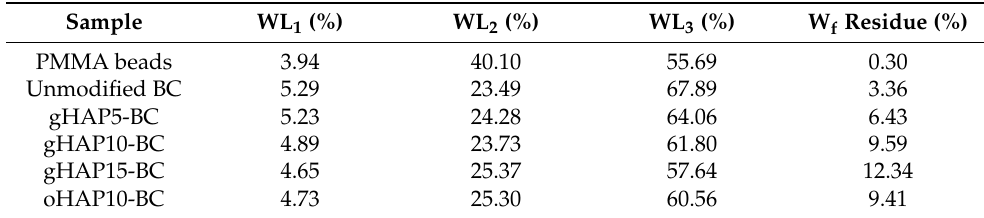
Table 4. TGA results of unmodified bone cement and HAP-modified bone